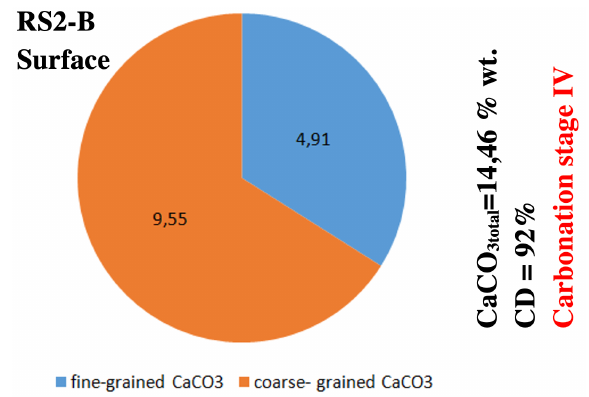
Figure 8. The amount of CaCO 3 (% wt.) in the surface layer of the unprotected concrete sample RS2- B.